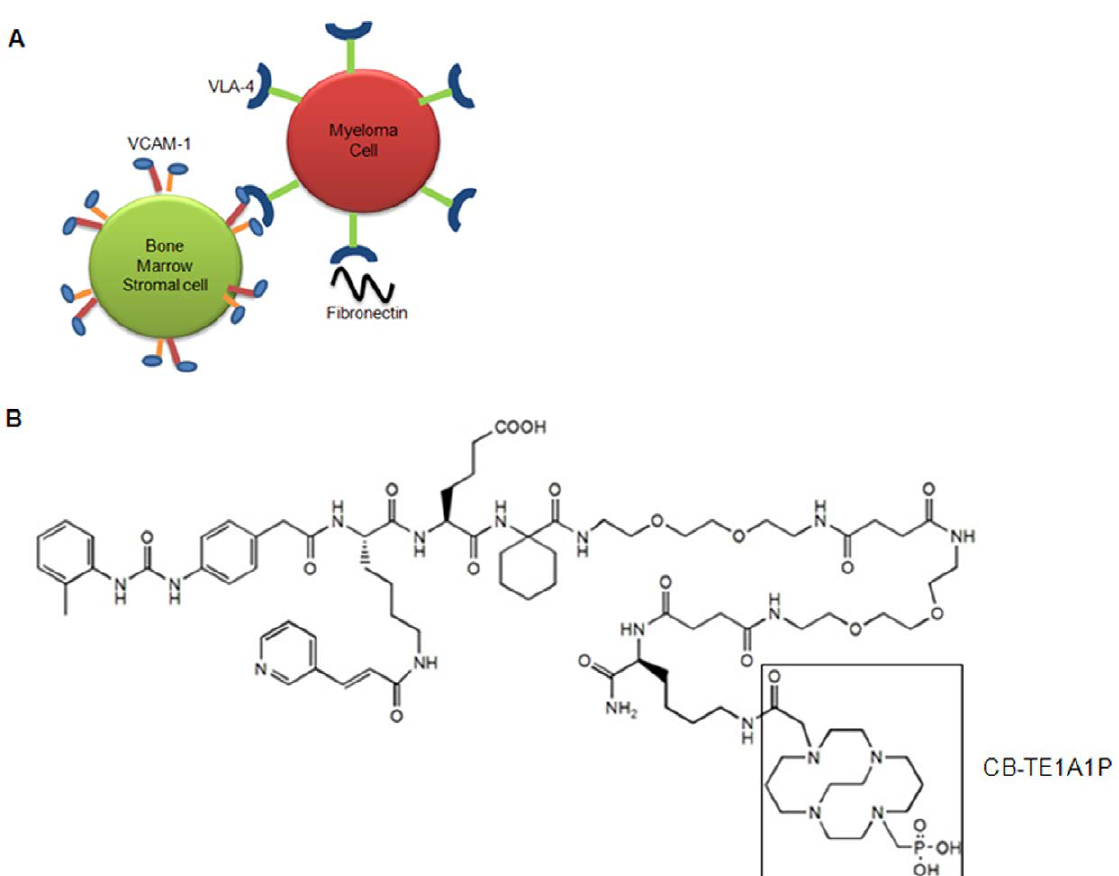
Figure 1. Schematic diagram depicting the interaction of multiple myeloma (MM) and stromal cells. A. Very late antigen-4 (VLA-4, also known as integrin a 4 b 1 ) is over expressed on MM cells. VLA-4 mediates myeloma cell adhesion to the bone marrow (BM) stroma through interactions with fibronectin, a glycoprotein of extracellular matrix (ECM) protein and vascular cell adhesion molecule-1 (VCAM-1) protein expressed on bone marrow (BM) stromal cells. B. Structure of CB-TE1A1P-LLP2A.